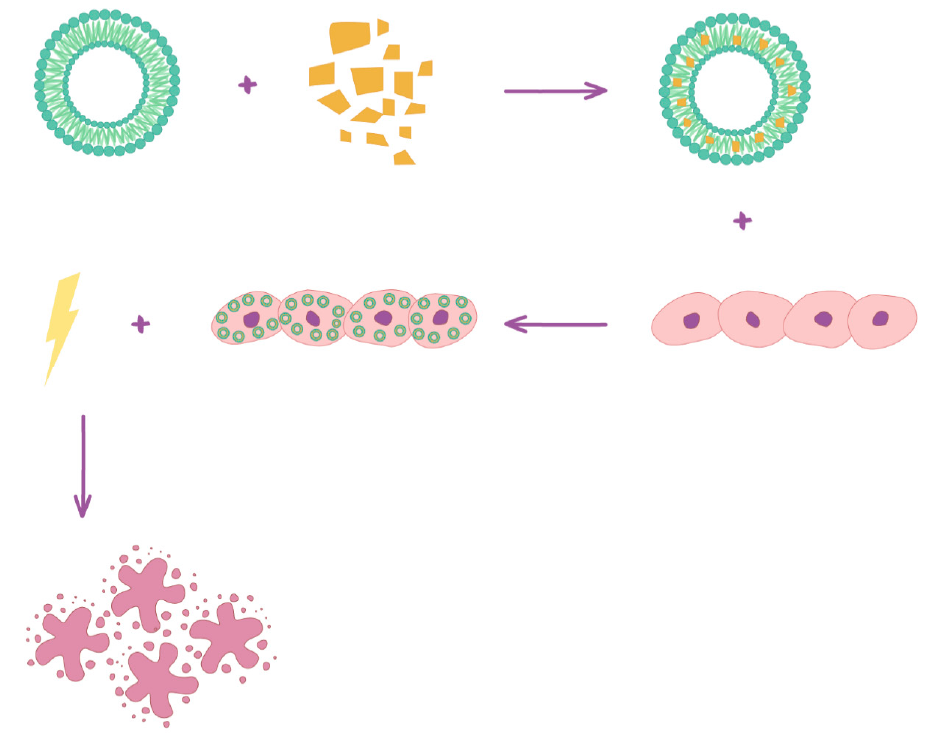
Figure 1. Scheme of encapsulated curcumin in liposomes and mechanism of photodynamic therapy.